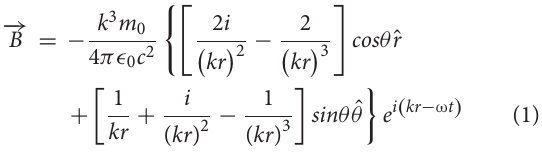
2Hz. Plotted on log-log scale with ∼